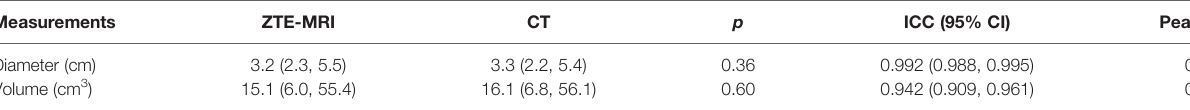
TABLE 3 | Inter-modality agreement for size measurements between ZTE-MRI and CT.